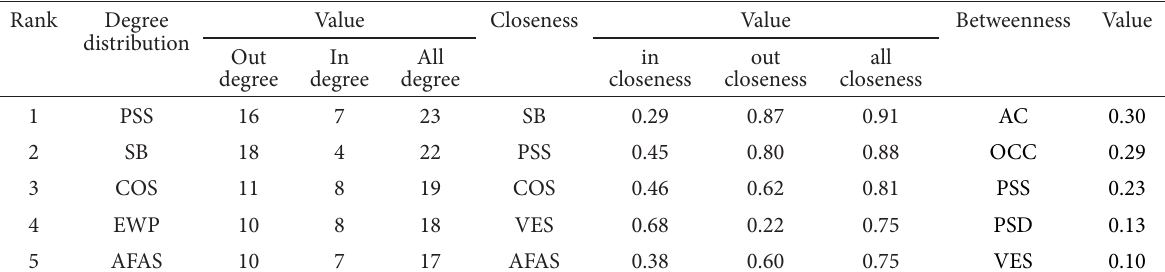
Table 5. Top 5 subsystems of three parameters in network